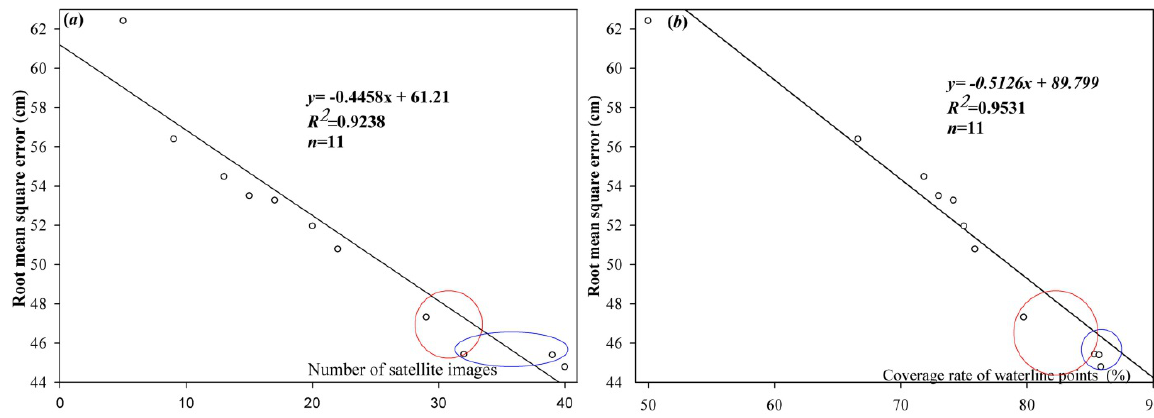
Figure 5. ( a ) Relationship between the number of satellite images used in the waterline method and the accuracy of the resultant DEMs; ( b ) relationship between the coverage rate of waterline points and the accuracy of the resultant